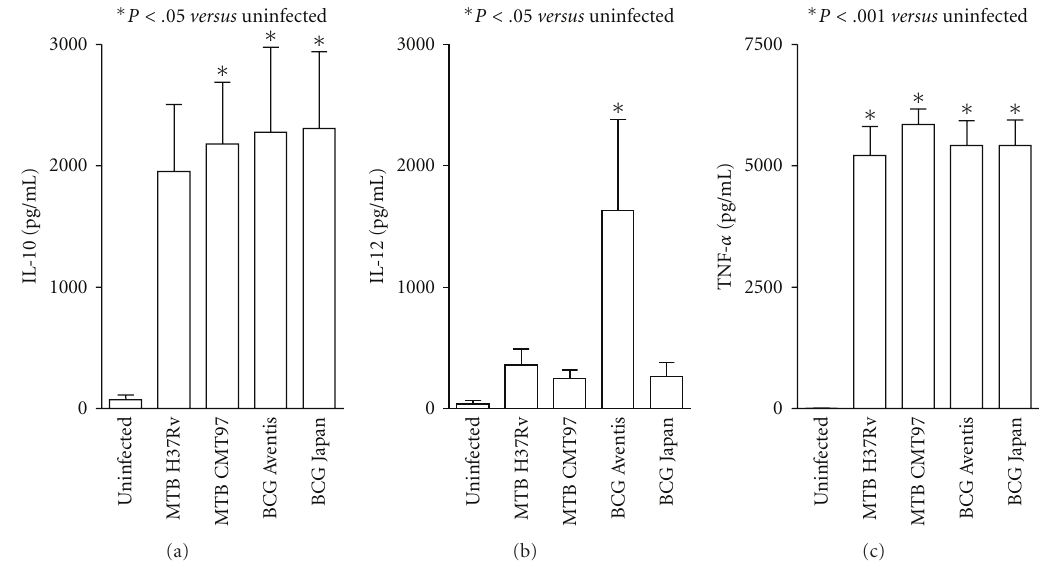
Figure 5: Evaluation of IL-10, IL-12 and TNF- α released from infected DCs. Cell supernatants derived from DCs uninfected or exposed to di ff erent mycobacteria strains as described before were collected at the end of the 24h of culture. IL-10, IL-12 and TNF- α were measured by ELISA. Data are represented as mean ± SEM from 3 independent experiments. The presence of significant di ff erences in the amount of cytokine released in the supernatant was calculated by a one-way